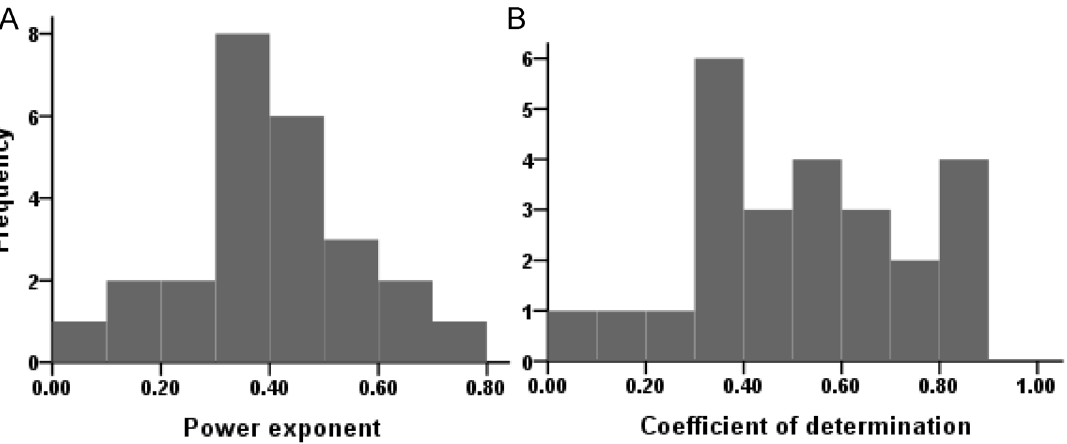
Figure 3. Regression parameters of power function. Power exponents (A) and coefficients of determination (B) for the relationship between sediment concentration and slope gradient for all tests.